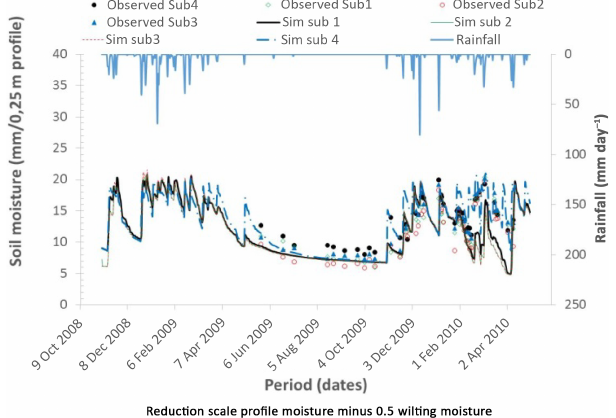
Figure 5. Model verification farm